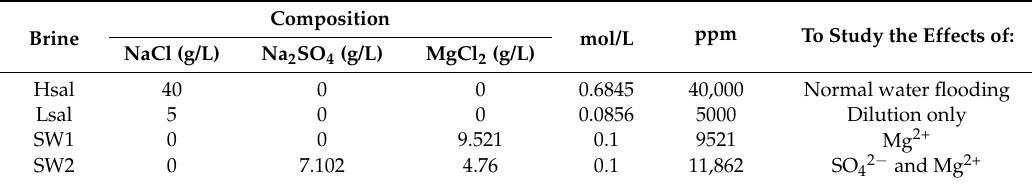
Table 1. Salt concentration in the brines used in the experiments. Hsal = high-salinity brine,